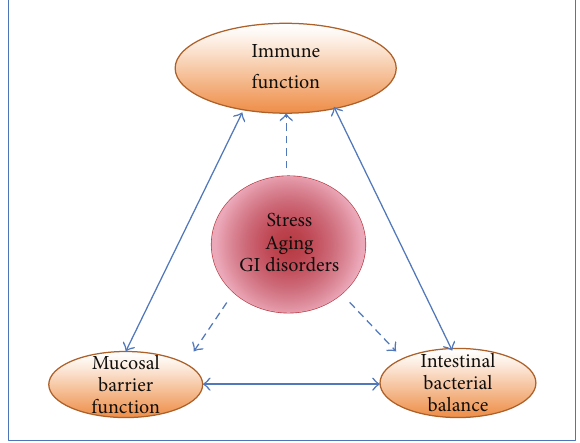
Figure 1: Triangle of three key elements closely linked to maintain host health: immune function is critical to maintaining the balance of these three elements. Once the host’s immune function is deteriorated by stress, aging, and other events such as GI disorders, the mucosal barrier system will be deteriorated along with an imbalance of intestinal bacteria, which eventually overcome the GI immunesystem. As a consequence, hostswith low immunefunction become more susceptible to these intestinal pathogens and fall into a downward spiral of chronic health